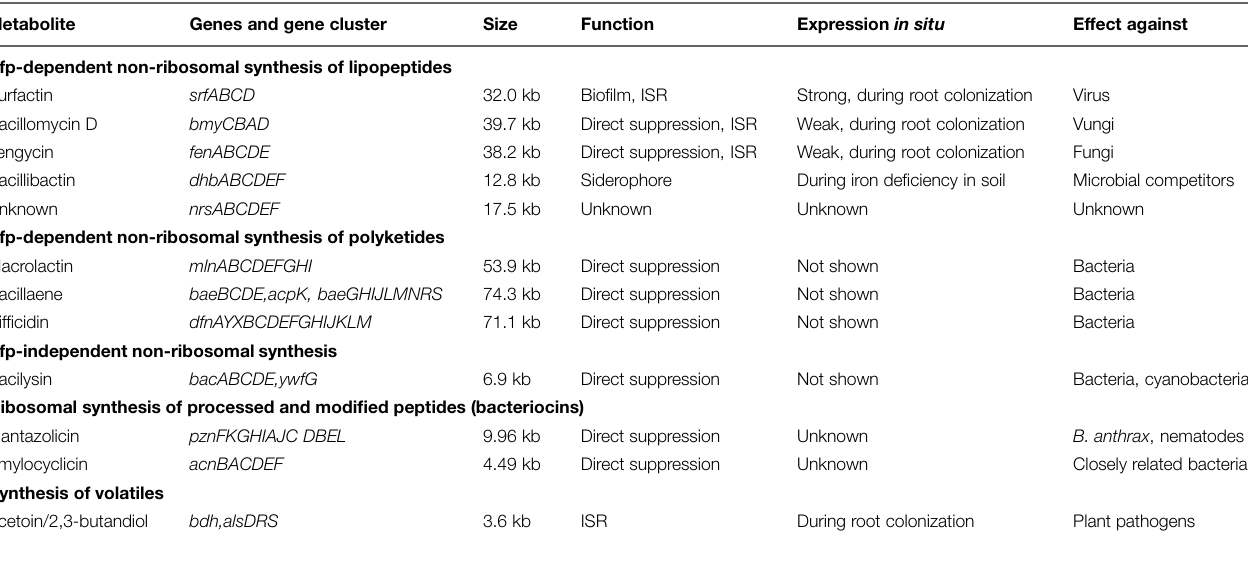
TABLE 1 | Genes and gene cluster encoding for biocontrol metabolites in Bacillus amyloliquefaciens plantarum FZB42.